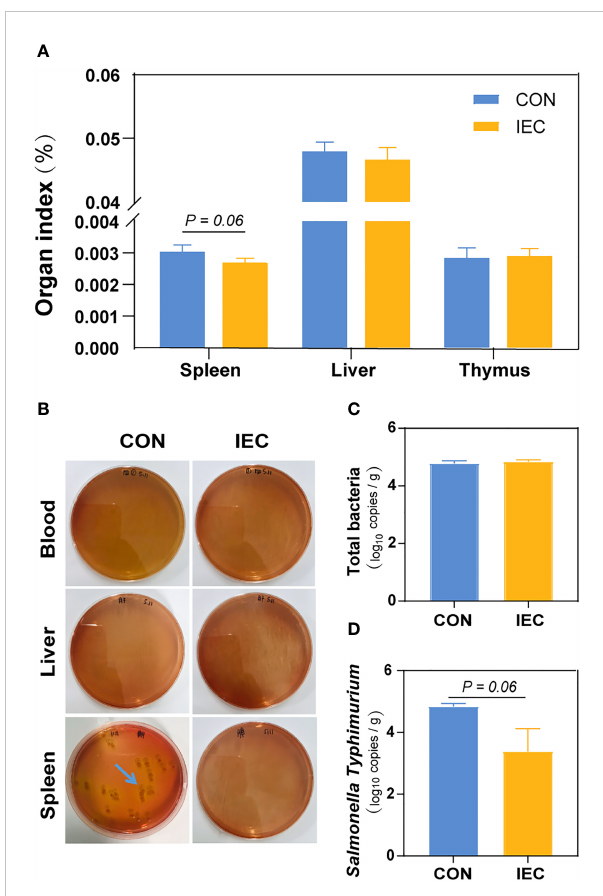
FIGURE 2 IEC pre-stimulation provided protection against Salmonella infections. (A) Organ indexes analysis of the spleen, thymus and liver of rats in the groups (n =10/group) at 48 hpi. (B) Bacterial burdens in organs and blood at 48 hpi were determined via DHL plates (n = 5/group). (C, D) Number of total bacteria and S.Typhimurium in spleen of rats (n =10/group) at 48 hpi. The data are presented as mean ± SEM. hpi, hours post